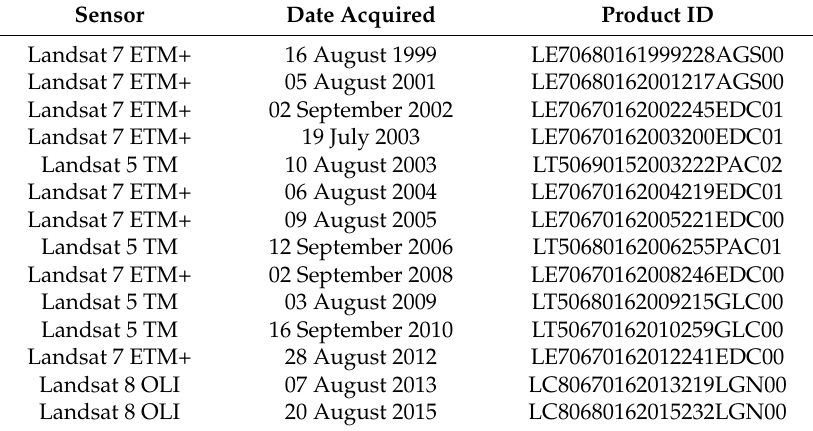
Table A1. Characteristics of the Landsat images used to estimate the